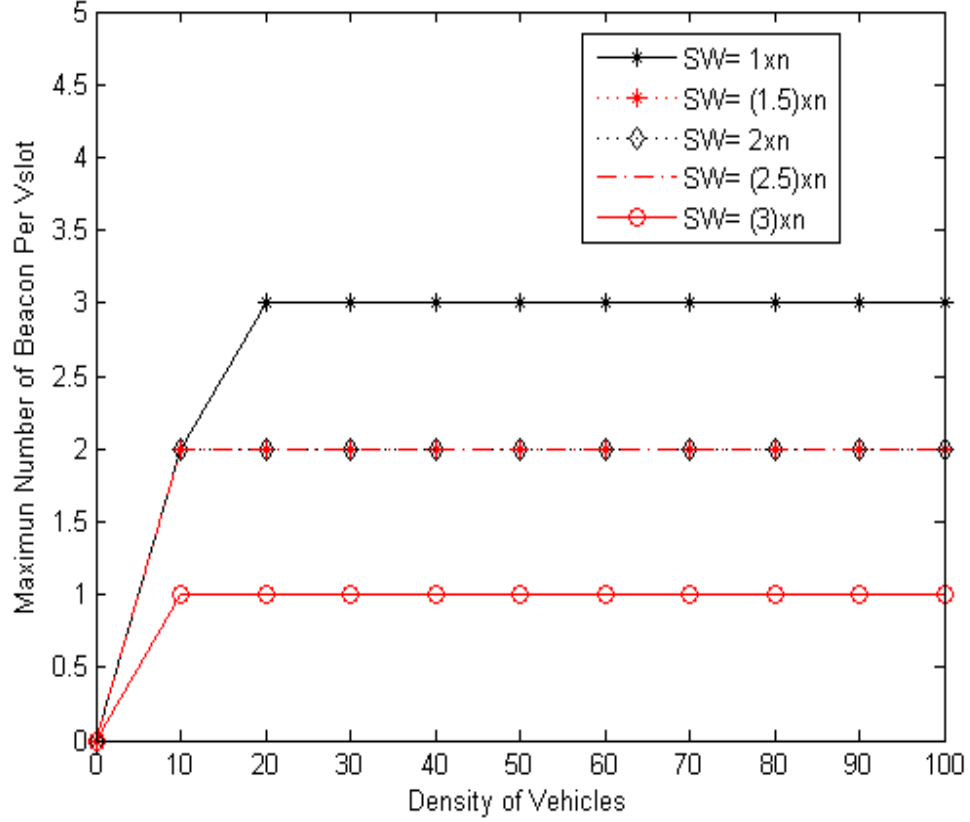
Figure 5. The maximum number of beacons per Vslot, compared to the density of vehicles and the size of the SW.